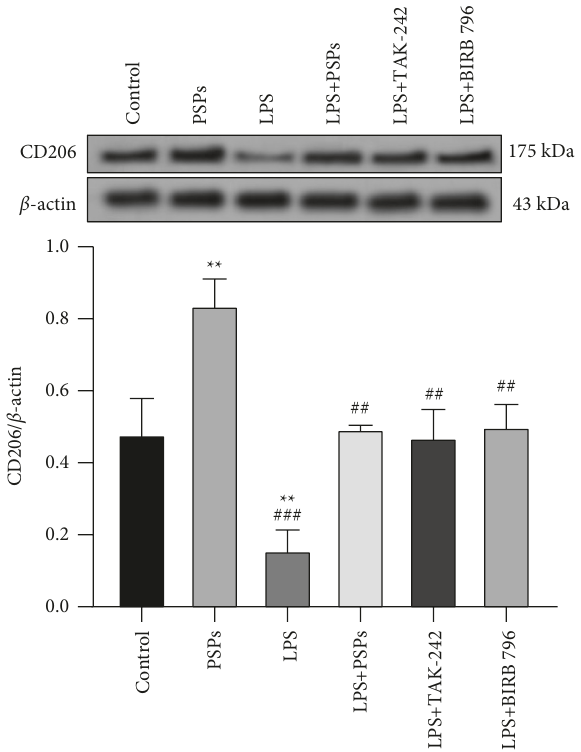
Figure 9: Verification of PSPs impact on M2 cell phenotype in RAW264.7 cells. Compared with control group, pared with LPS group, ##